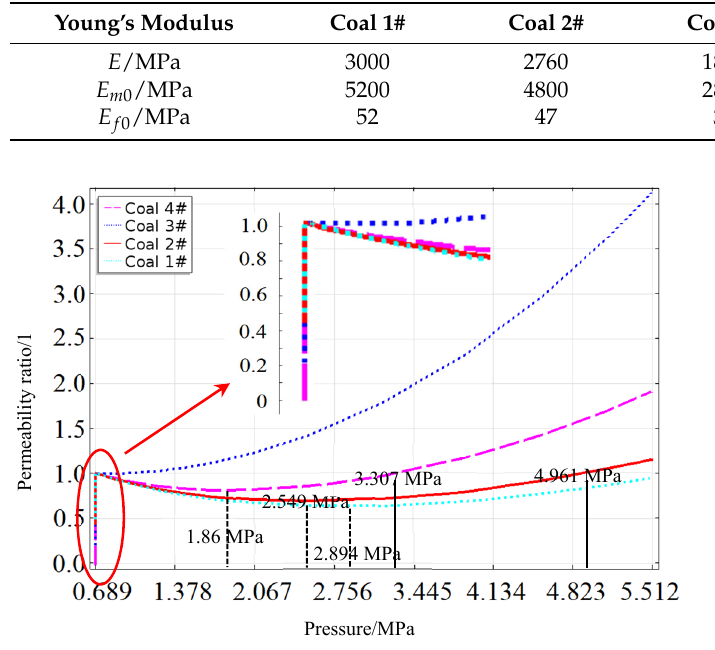
Figure 10. Permeability changes under different coal modulus.